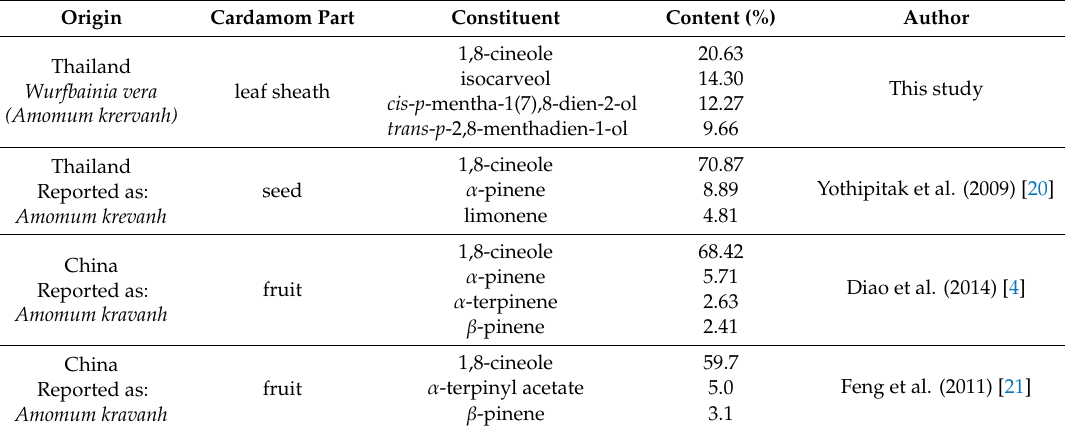
Table 3. Major constituents of extracted essential oil of several studies relating to cardamom oil